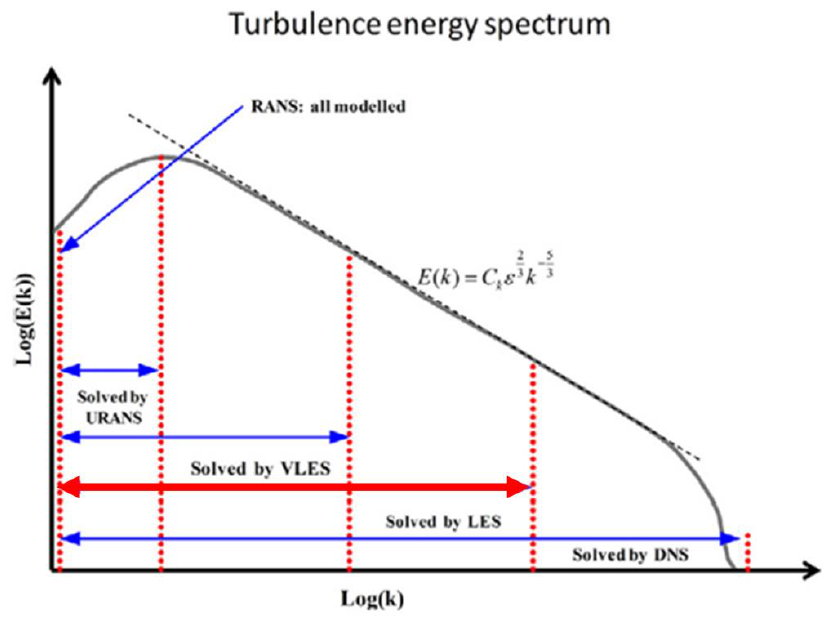
Figure 3. Schematic representation of turbulence energy spectrum and different modeling approaches from URANS to DNS and the associated required levels of modeling resolution [9].